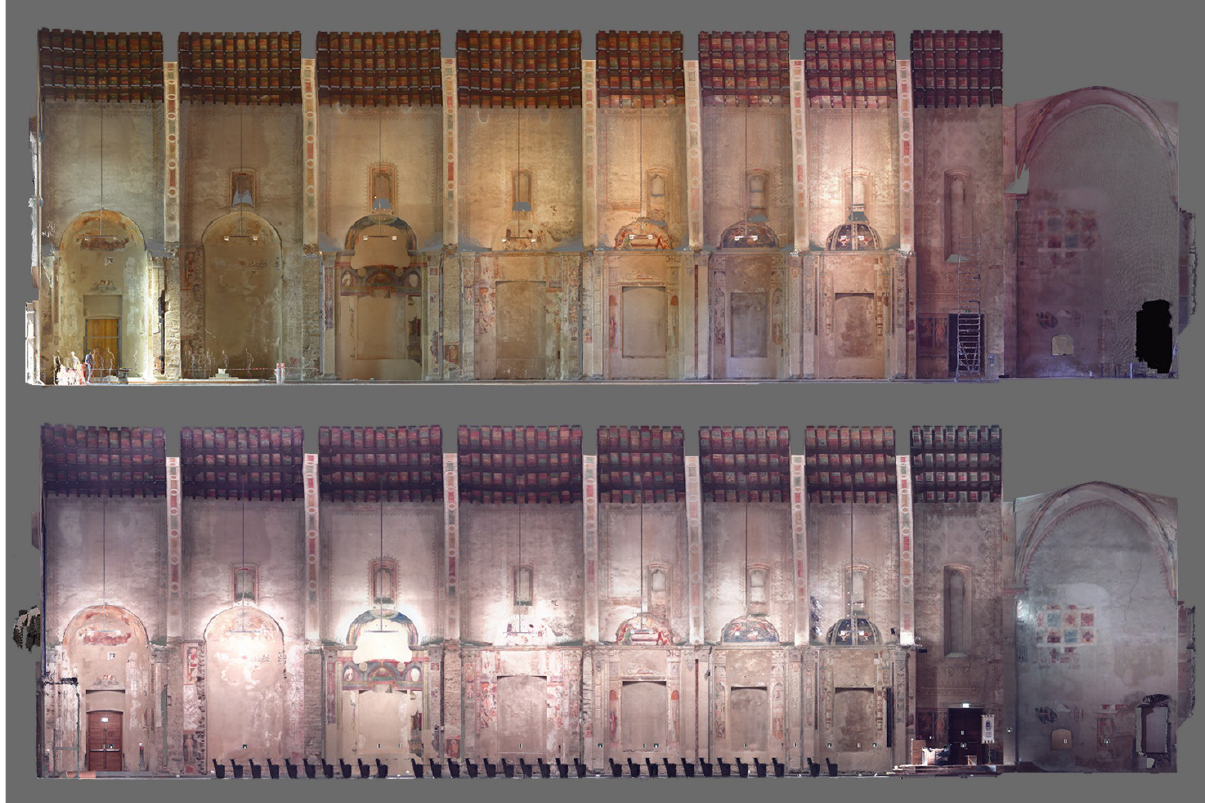
Figure 5. The left side of the nave of the former church of Sant’Agostino during and after restoration works. Comparison between the orthographic projections with the goal of monitoring the degradation evolution (surveys carried out in July 2015 and March